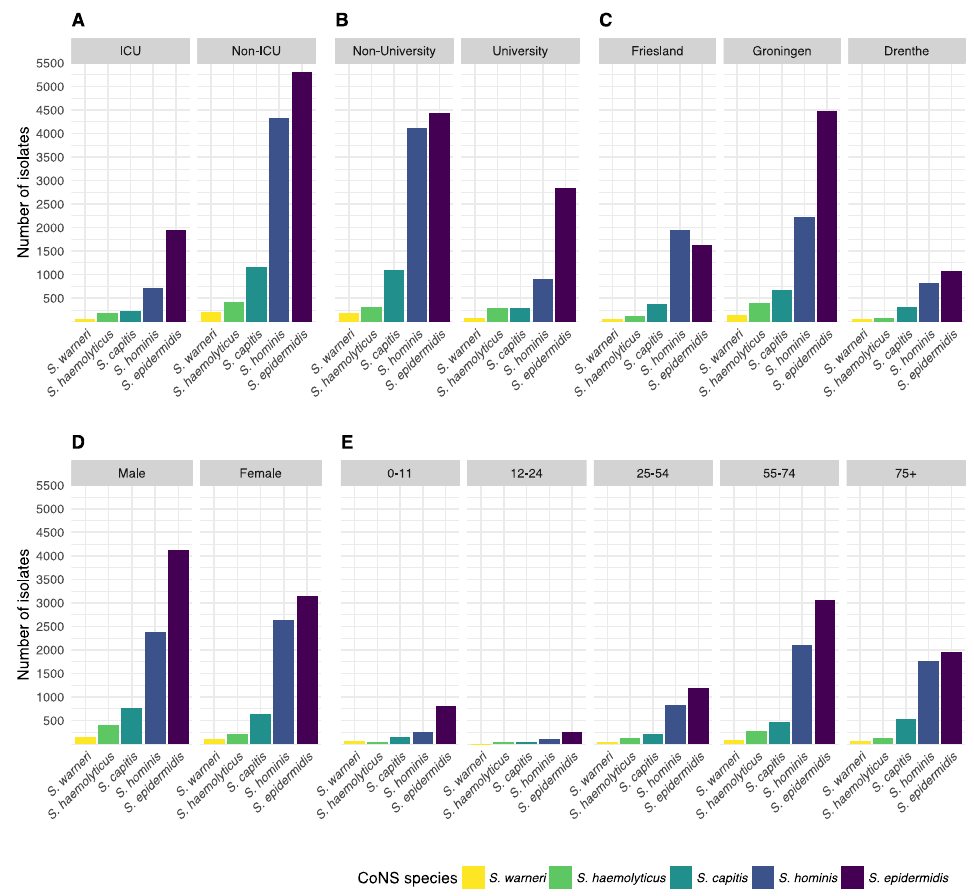
Figure 2. The number of first weighted isolates of the top five CoNS species found in the study stratified by ( A ) type of care, ( B ) type of hospital ward, ( C ) province of the Netherlands, ( D ), gender, and ( E ) age group.